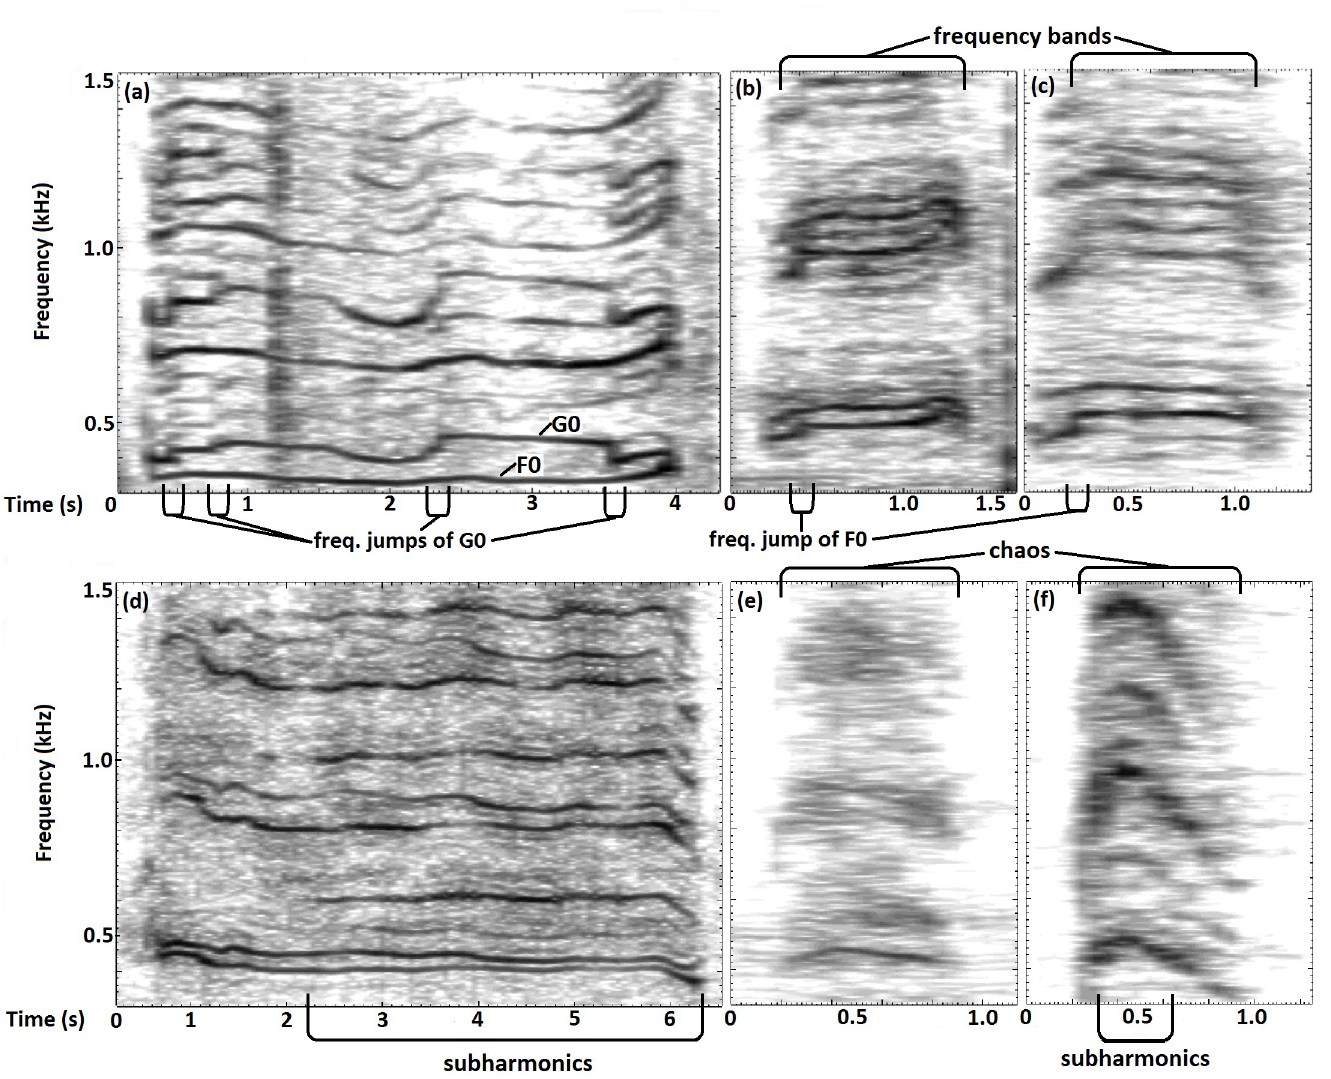
Fig 2. Spectrographic representations showing the acoustic variation and different types of NLP in trumpets of different individuals. (a) Chan Chun–S1 Audio, (b) Sunder, (c) Saraswati, (d) Dhibya, (e) Dipendra, (f) Sona–S2 Audio.